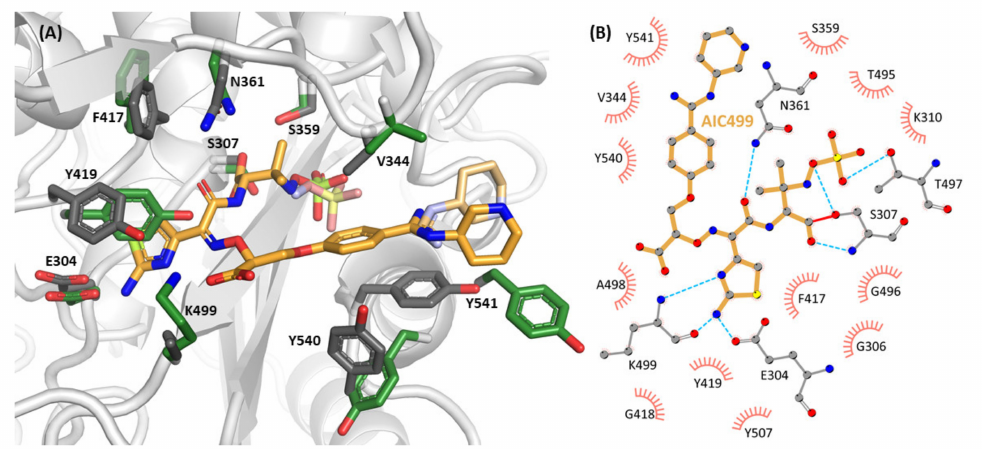
Figure 4. Structure of AIC499 within the active site of Ec TPd*. ( A ) 3D representation of the covalently bound ligand together with the most relevant interacting side chains (gray) and their counterparts in the apo structure (green). The second conformation of the amidine-based head group, as well as the terminal sulfate moiety are shown in lighter color. Note that K499 has been truncated in the complex structure because of missing electron density. ( B ) LigPlot+ representation of individual contacts for one conformer. Hydrogen bonds (cyan) are plotted for donor-acceptor distances between 2.3 Å and 3.2 Å, while hydrophobic interactions (salmon) have distances between 3.0 Å and 4.0 Å. A complete list of distances between protein side chains and the AIC499 compound is provided in Table